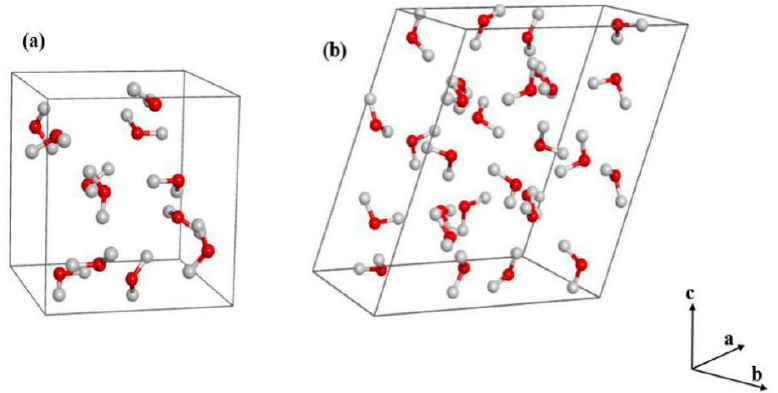
Figure 8. The crystal structures of ice IX ( a ) and XIII ( b ). The red and grey spheres represent the oxygen and hydrogen atoms, respectively.